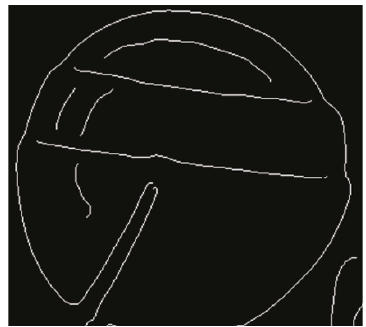
Figure 11: Image after edge detection using Canny operator.